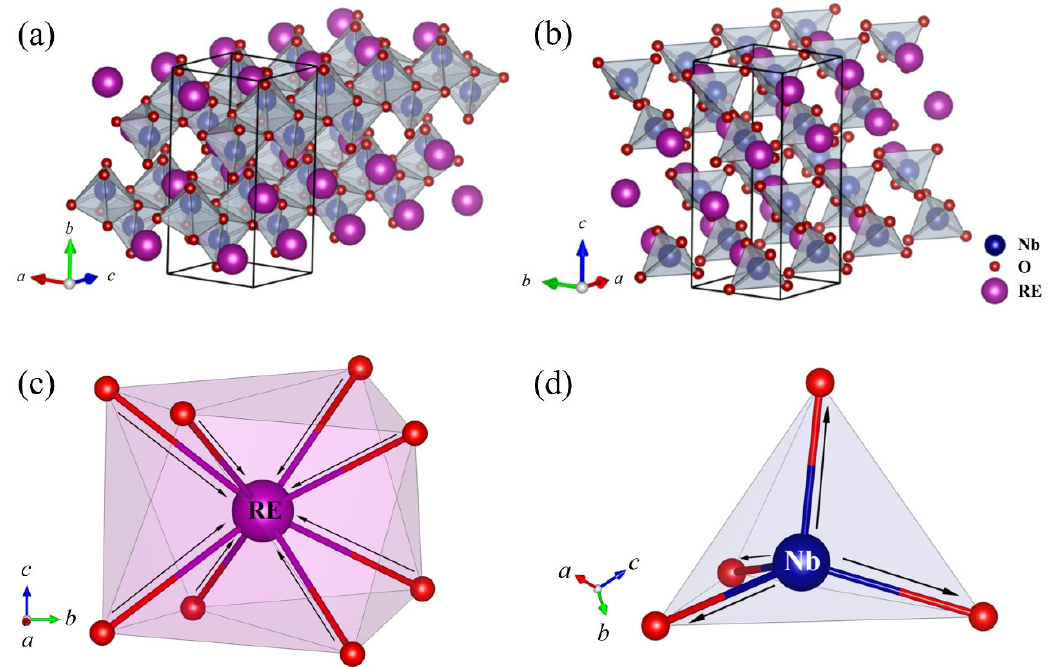
Fig. 10 Crystal structures of RENbO 4 : (a) fergusonite-type crystal structure of m-phase, (b) scheelite-type crystal structure of t-phase, (c) REO 8 dodecahedron, and (d) NbO 4 tetrahedron. Reproduced with permission from Ref. [77], © Acta Materialia Inc.